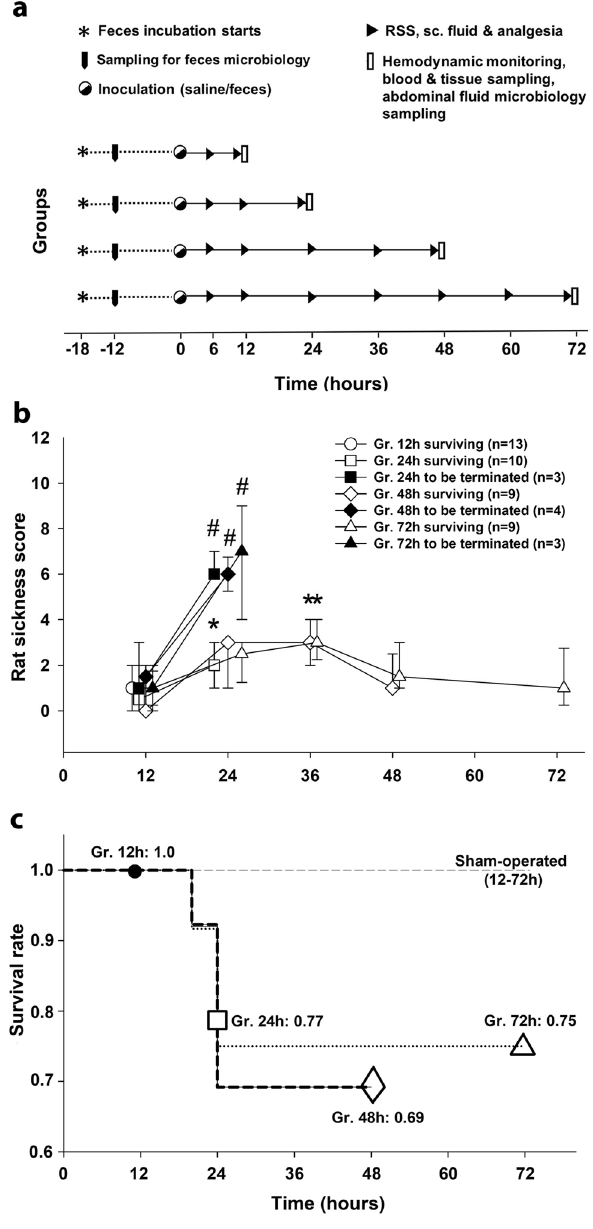
Figure 1. Experimental protocol, rat-specific sickness score (RSS) and mortality at different stages of the sepsis. (a) The scheme for the experimental protocol (groups, interventions and assessments). The animals were randomly assigned to sham-operated and septic groups, which were further divided into four independent groups each according to the termination timeline set between 12 and 72 h. Interventions and assessments (including RSS score) are marked with symbols. The animals were injected with an inoculum fitting the 1.02 × 10 6 –5.6 × 10 6 CFU range. This dosing regimen caused marked RSS changes and organ dysfunction leading to approximately 20% mortality in a pilot study (see Supplementary Material S1). (b) Within the cohort of septic animals, RSS score values of surviving animals (open symbols) and those reaching the threshold value of 6 (euthanized subjects; black symbols) are shown separately ( Grs. groups). Plots demonstrate the median values and the 25th (lower whisker) and 75th (upper whisker) percentiles. Within groups: Friedman test and Dunn’s post-hoc test. * P < 0.05 vs value of non-lethal 12 h sepsis. Between groups: Mann–Whitney U test. # P < 0.05 lethal vs non-lethal sepsis at 24 h. (c) Kaplan–Meier survival analysis performed on the four sepsis groups (Grs. 12 h, 24 h, 48 h and 72 h) and four sham-operated groups; survival rates are